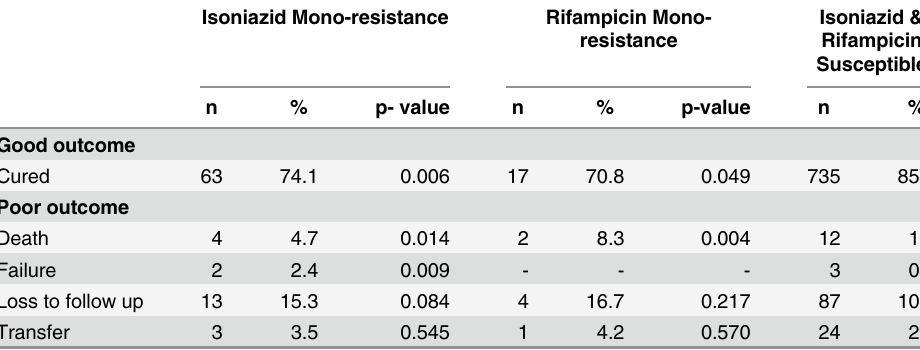
Table 4. End of Treatment Outcomes for Isoniazid and Rifampicin Mono-resistant TB Cases. Isoniazid